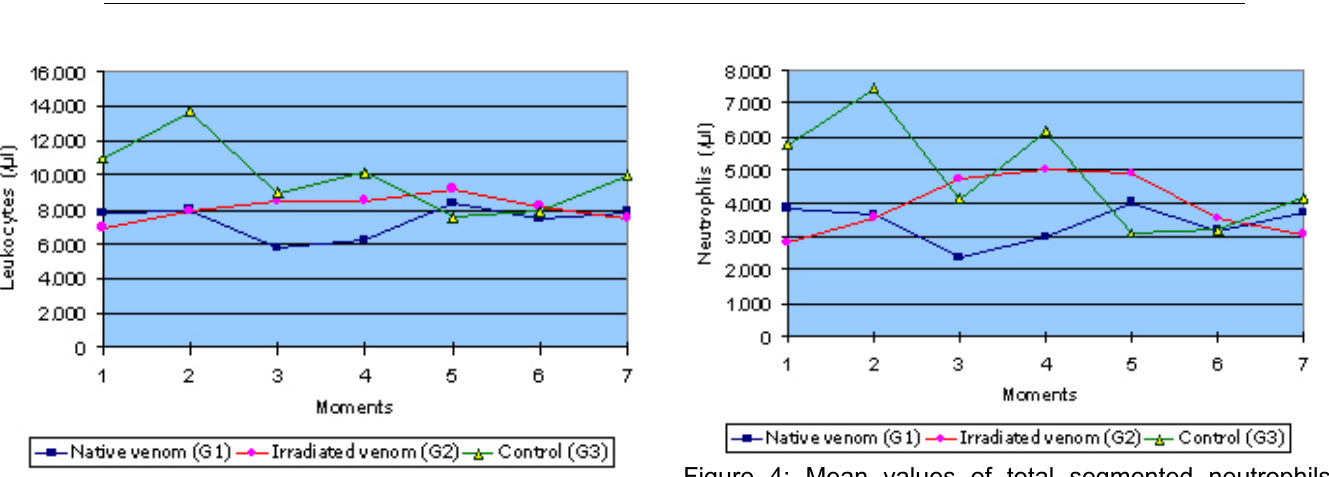
Figure 3: Mean values of total leukocytes count (/µl) in ovine groups inoculated with natural (G1) and 60 Co-irradiated (G2) C.d.t. venom, and control group (G3), at different moments.